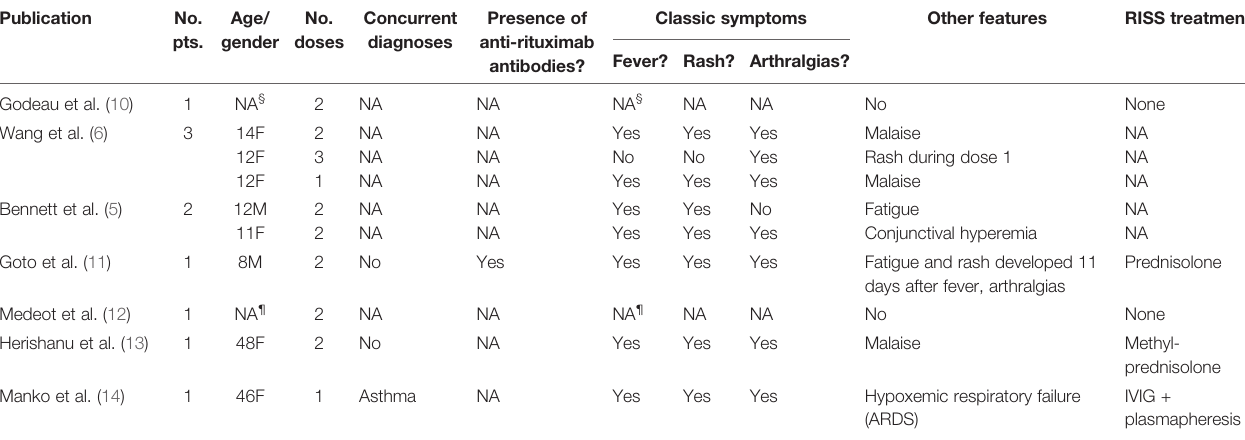
TABLE 1 | Previously published case reports of rituximab-induced serum sickness in patients with immune